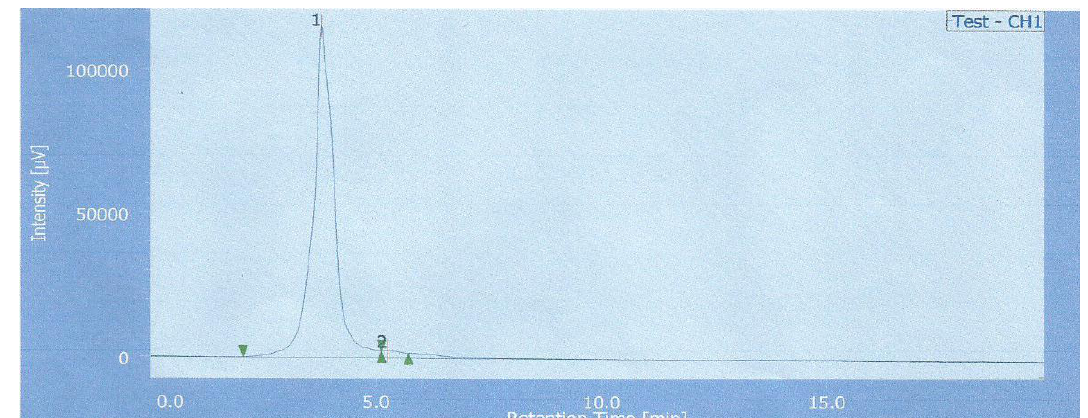
Figure (8):- HPLC analysis of isolated and purified Tigogenin.